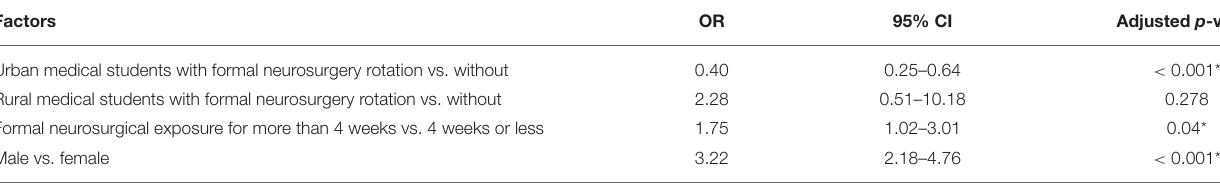
TABLE 4 | Neurosurgical career interest based on adjusted logistic regression model. Factors OR 95% CI Adjusted p -value Urban medical students with formal neurosurgery rotation vs. without 0.40 Rural medical students with formal neurosurgery rotation vs.